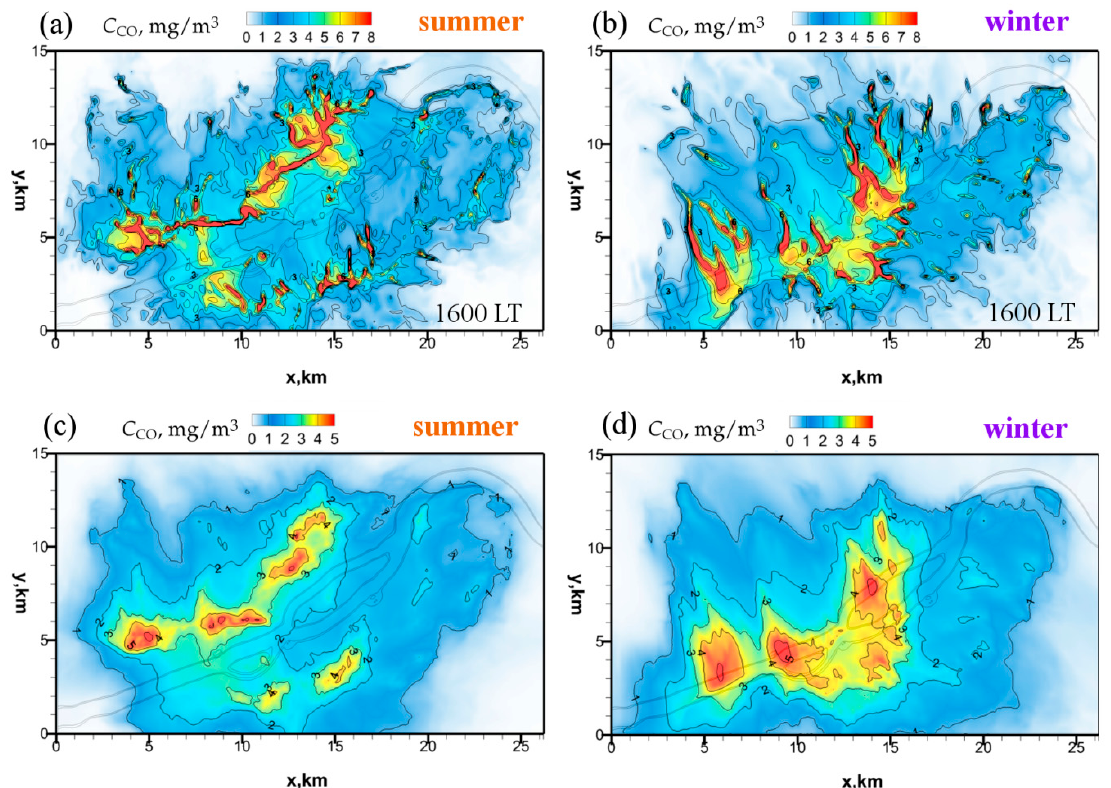
Figure 7. CO concentration distribution in a horizontal cross-section at 50 m above the ground ( a , b ) Instantaneous (1600 LT) plots; ( c , d ) Daily averaged plots; ( a , c ) Summer case; ( b , d ) Winter case.